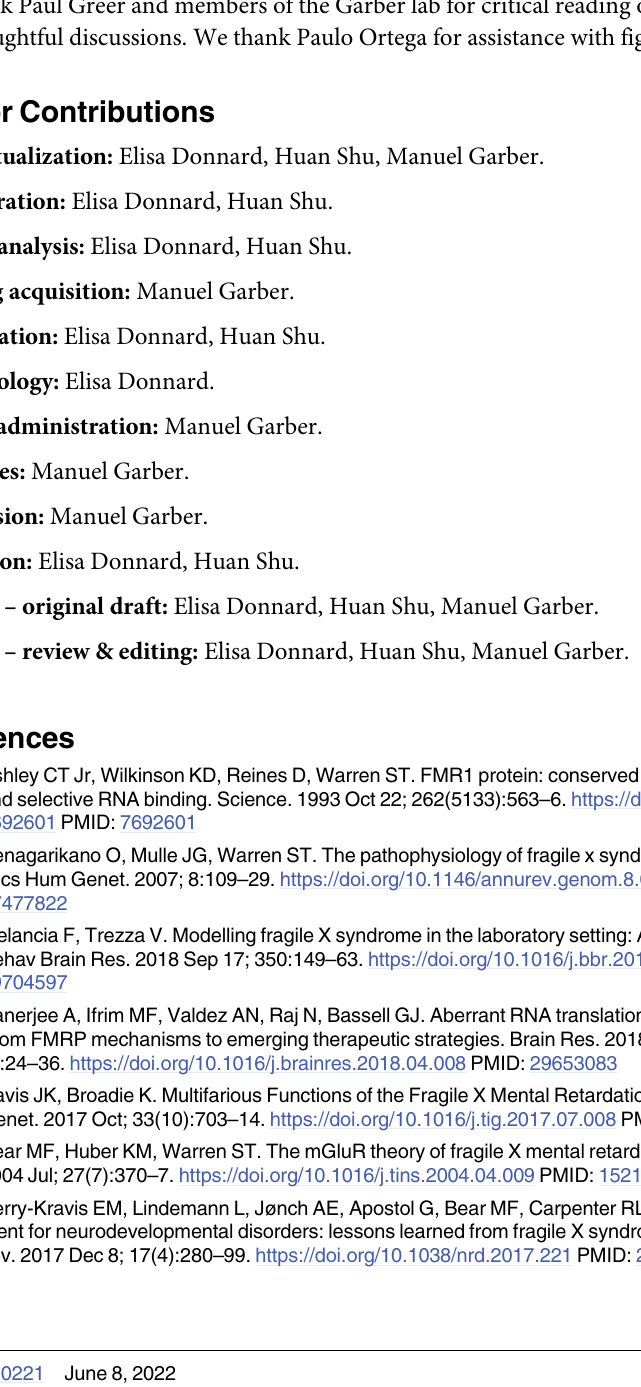
S3 Table. Metadata for each mouse cortex single cell RNA-Seq library generated. S4 Table. Overlap results between genes detected as downregulated or upregulated in one or more cell types and previously published lists of mRNAs bound by FMRP. Significant overlaps are shaded in